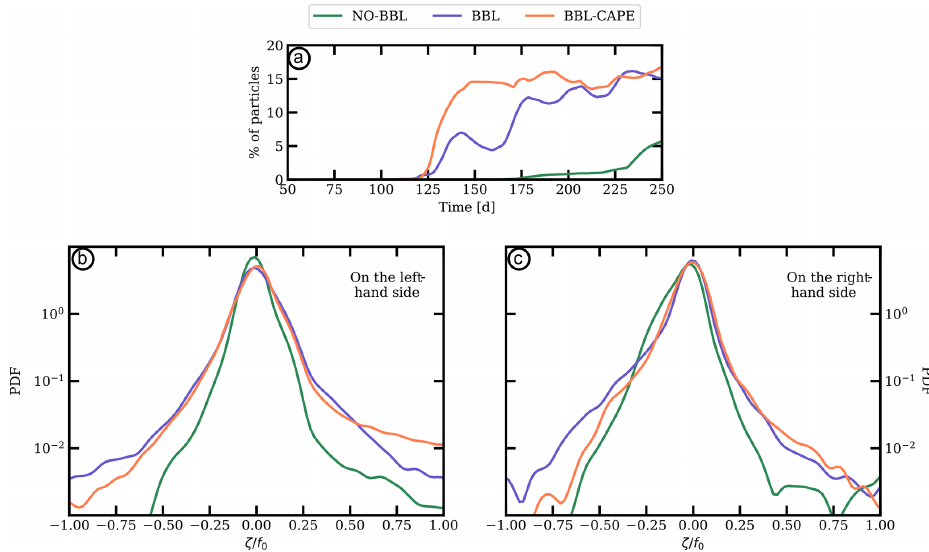
Figure 14. (a) Time evolution of the percentage of particles lying in x ∈ [ 400 ; 600 ] km the three experiments: (green) NO-BBL, (blue) BBL and (orange) BBL-CAPE. (b, c) Probability density function of the relative vorticity normalized by the planetary rotation associated with particles on the left- ( x < 300km) and right-hand sides ( x > 300km) of the domain regarding (green) NO-BBL, (blue) BBL and (orange)